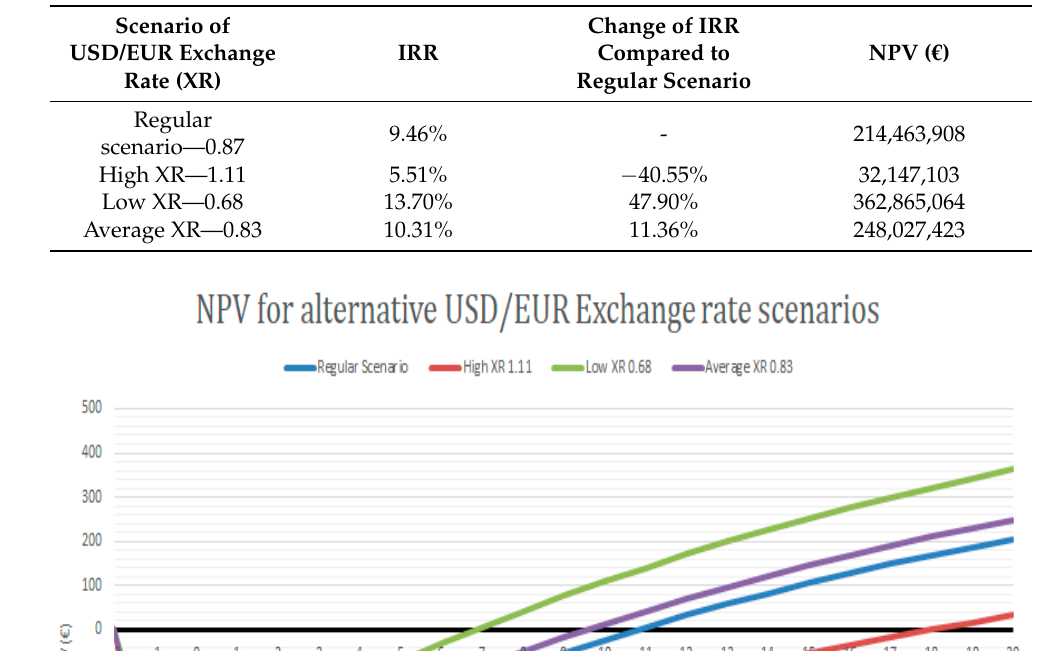
Table 3. Results of USD/EUR exchange rate sensitivity analysis.